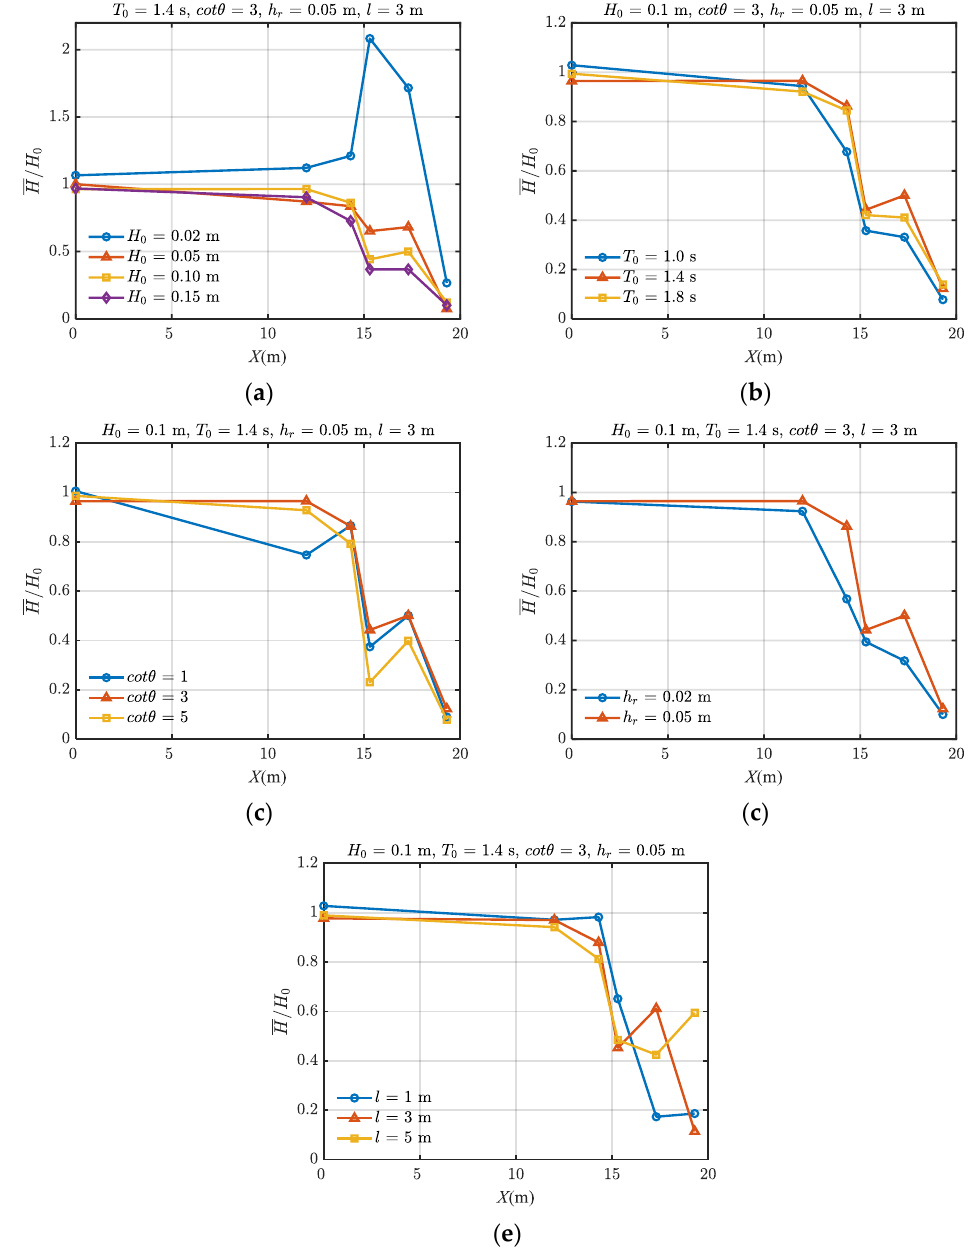
Figure 8. Regular wave height transformation for the vertical seawall on the reef flat for different cases: ( a ) H 0 ; ( b ) T 0 ; ( c ) cot θ ; ( d ) h r ; ( e ) l .